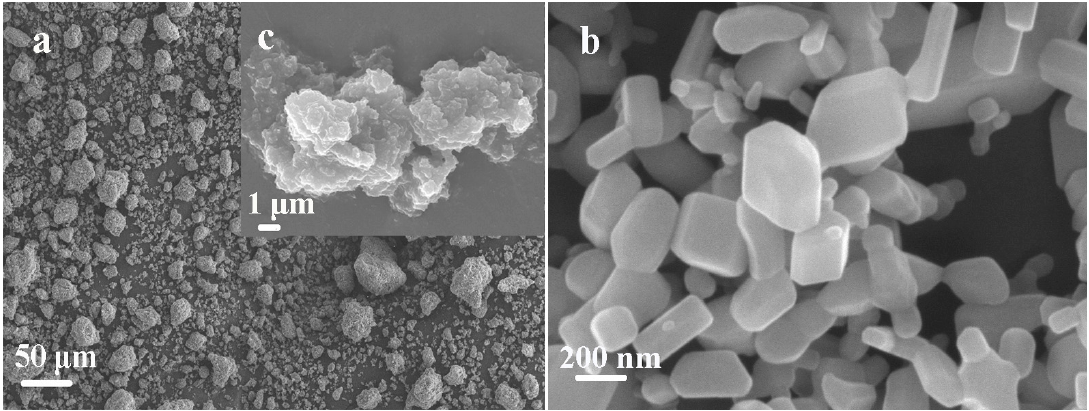
Figure 1. Micrographs of ( a , c ) amorphous SiO 2 and ( b ) pure ZnO.